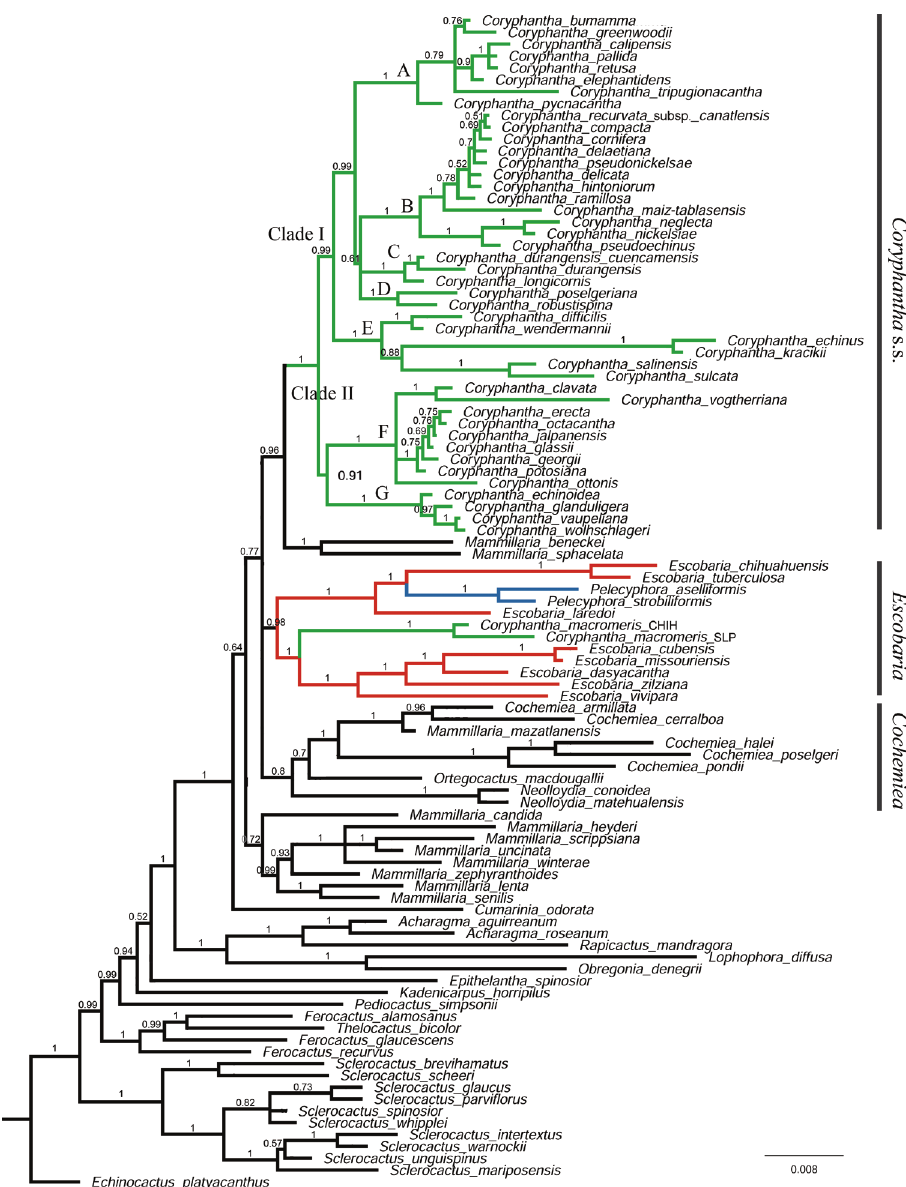
Figure 1. Phylogenetic relationships of Coryphantha and close related genera. Majority rule phylogram, from the BI analysis using cpDNA sequences and indels partitions (molecular analysis). Numbers in nodes indicate posterior probabilities. Labels indicate the main recovered clades and